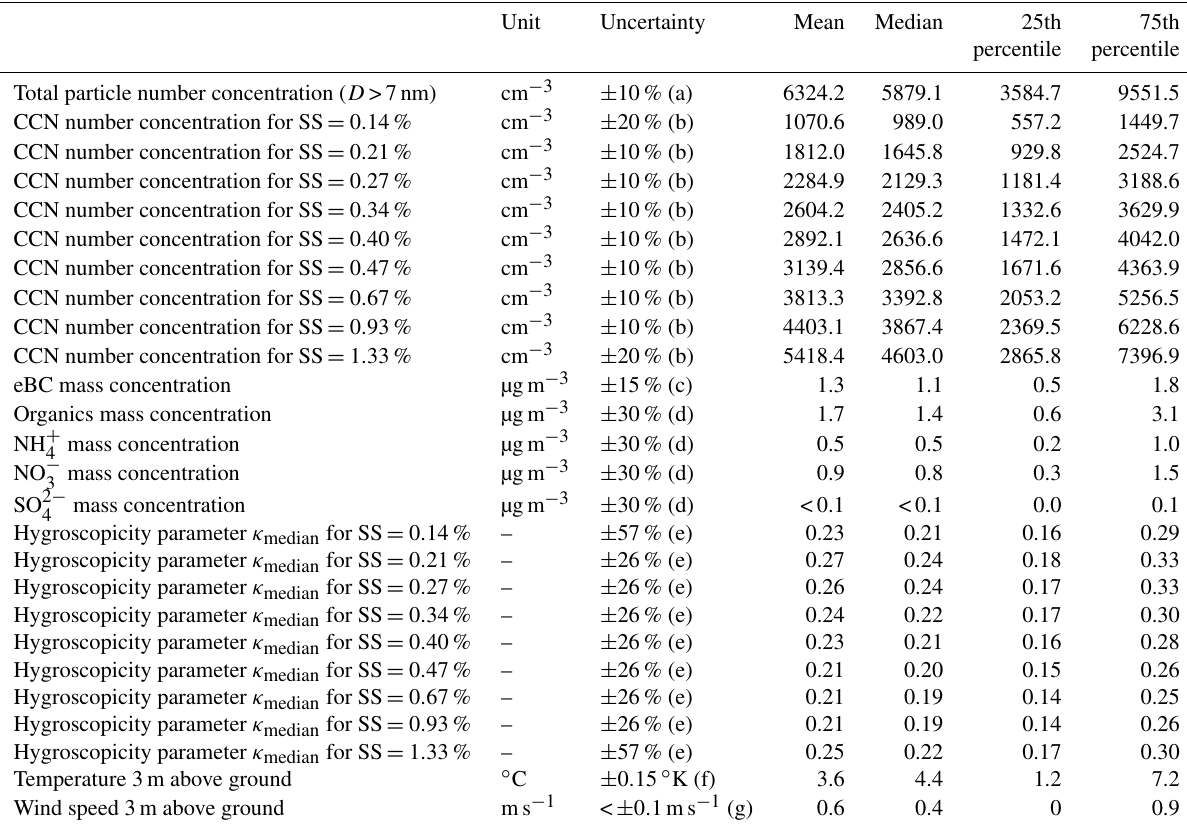
Table 1. Statistics of various measured and inferred parameters from data covering the whole campaign. Uncertainties: (a) in the CPC model 3022 according to the ACTRIS standard operation procedures (SOP; http://fp7.actris.eu/Portals/97/deliverables/PU/WP3_D3.13_M24.pdf, last access: 17 January 2019); (b) see Sect. 2.2.1; (c) instrument precision only (see Sect. 2.2.3); (d) based on the studies of Middlebrook et al. (2012) and Budisulistiorini et al. (2014); (e) based on the accuracy of the SS set by the CCNC and the uncertainty in the retrieval of D sCCNC ; (f) reported as accuracy in the instrument manual of Meteolabor AG crit